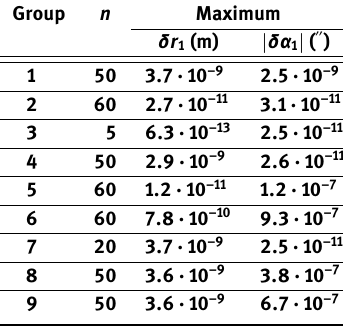
Table 2. Maximum point errors δr 1 and errors δα 1 of the azimuth of the solutions of the direct problem satisfying the error limits